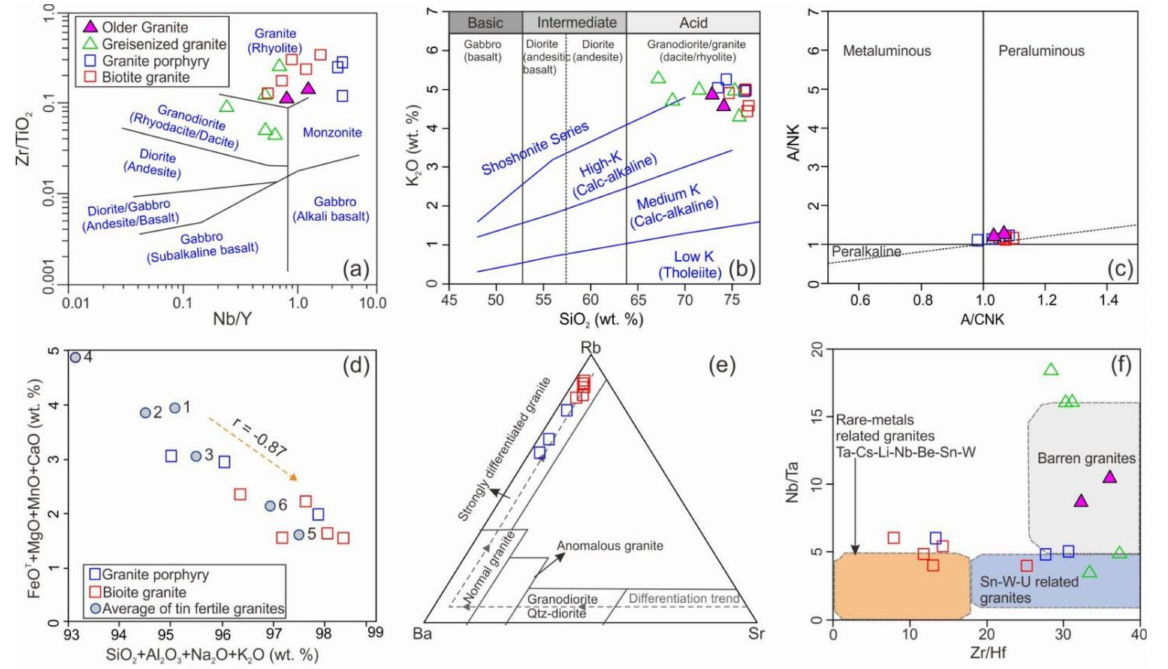
Figure 7. Classification and discrimination diagrams for Older Granite, greisenized granite, and Younger Granite (including granite porphyry and biotite granite) from the Gindi Akwati deposit. ( a ) Zr/TiO 2 vs. Nb/Y diagram following the classification of Vry et al. [20], as modified from the classification diagram for volcanic rocks of Winchester and Floyd [21]; ( b ) SiO 2 vs. K 2 O binary plot that covered dispersion from potassic alteration following the classification of Vry et al. [20], as modified from classification diagram of Peccerillo and Taylor [32]; ( c ) ASI vs. A/NK diagram (after [33]); ( d ) Binary variations between acidic (SiO 2 + Al 2 O 3 + Na 2 O + K 2 O) and mafic (FeO T + MgO + MnO + CaO) constituents of tin fertile granitic rocks (after [24]). Orange dashed arrow represents the trend of correlation of major elements. The r value shows the correlation coefficient. 1 = Malaysia, 2 = Cornwall, 3 = Tasmania, 4 = Bushveld, 5 = Alaska, 6 = Nigeria; ( e ) Diagram of Rb-Ba-Sr (after [25]) which shows the granite porphyry and biotite granite are strongly differentiated; ( f ) Diagram of Nb/Ta vs. Zr/Hf (after [34]). The Older Granite and greisenized granite mainly plot in the area of barren granites, whereas granite porphyry and biotite granite mainly plot in the area of rare-metals-related granites (Ta-Cs-Li-Nb-Be-Sn-W) and Sn-W-U related granites.